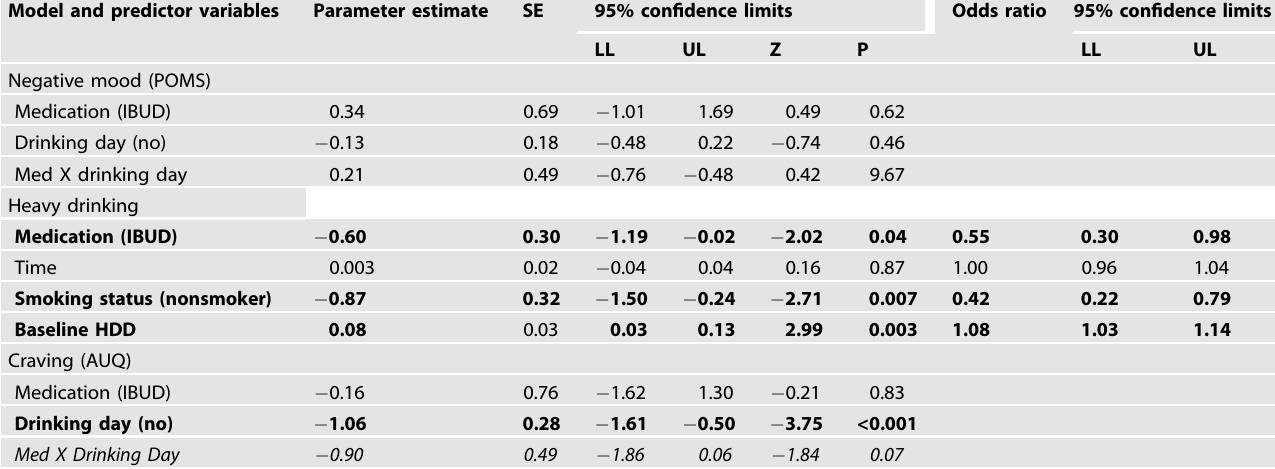
Table 2. Effect of ibudilast on heavy drinking and craving.